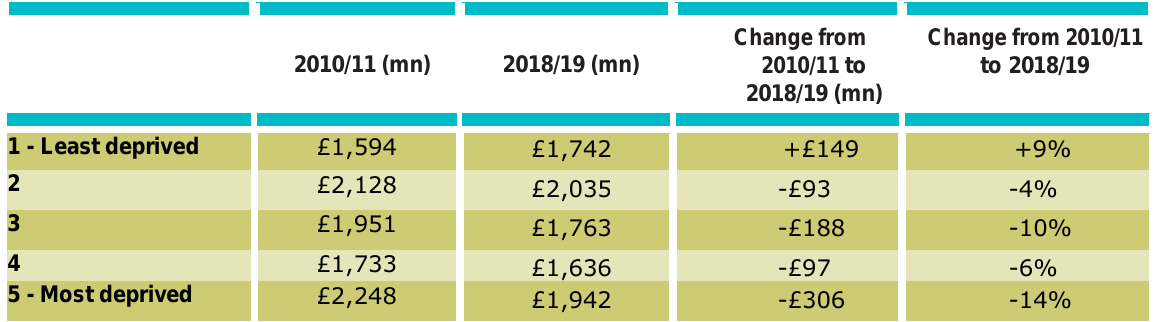
Table 4: Spending on children and young people’s services by deprivation in real terms